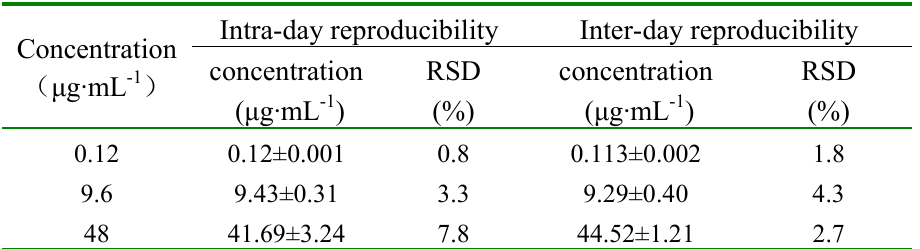
Table 6. Intraday and Interday Reproducibility of Chlorzoxazone (mean±SD, n=3. ）